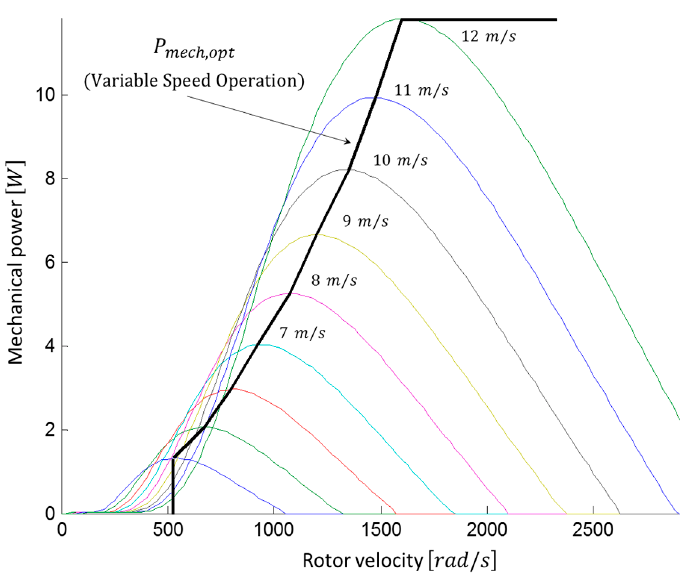
Figure 4. Mechanical power of the DFIG as a rotor speed function.